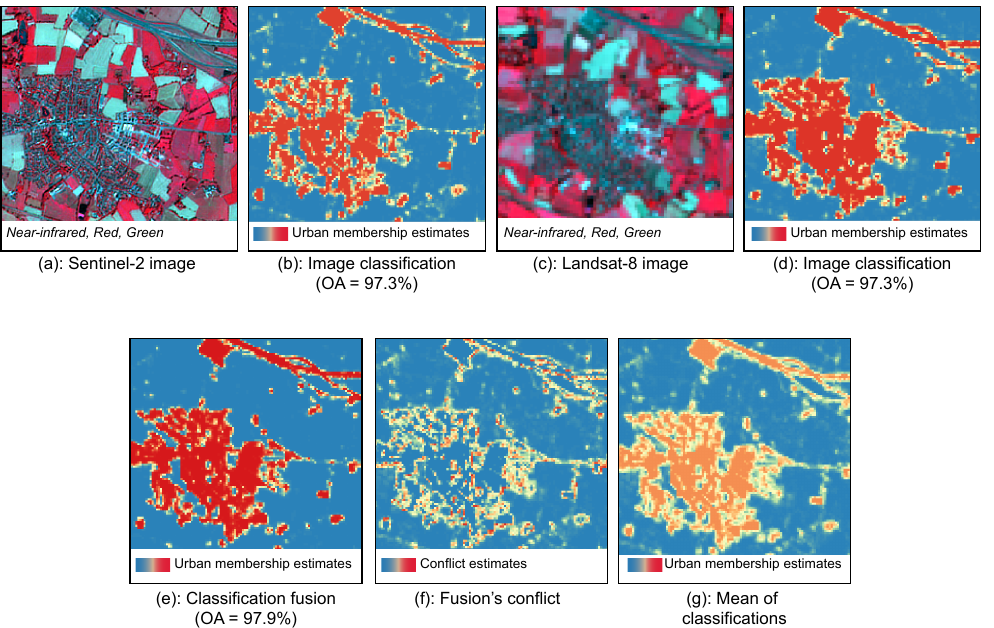
Figure 10. Benefits of the multi-source fusion: classification fusion provides sharpened edges, whereas the mean of classifications is more inaccurate. ( a ) Landsat-8 image; ( b ) Image classification (OA = 97.3%); ( c ) Landsat-8 image; ( d ) Image classification (OA = 97.3%); ( e ) Classification fusion (97.9%); ( f ) Classification’s conflict; ( g ) Mean of